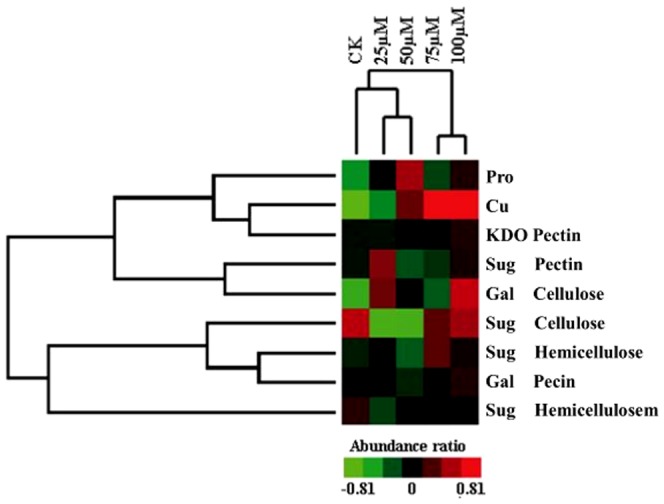
Hierarchical cluster result of cell wall polysaccharide abundance ratio using the average linkage distance between clusters is shown.The color weighting represents normalized levels of each variable from the high (red) to the low (green).